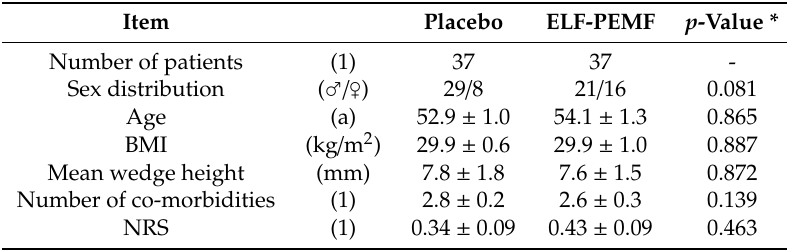
Table 1. Age, sex, wedge height, body mass index (BMI), comorbidities, and nutritional status (NRS) of the study cohort prior to surgery.